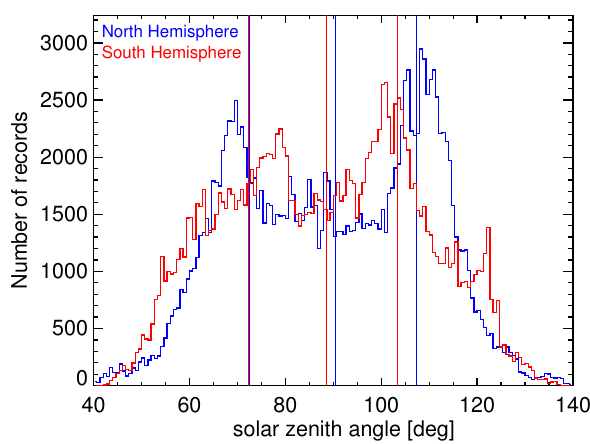
Fig. 2. Solar zenith angle distributions at the ionospheric footpoint location of the mapped EDI drift vectors in the ionosphere for North (blue) and South (red) Hemisphere separately. The vertical lines indicate the quartiles of the distributions.